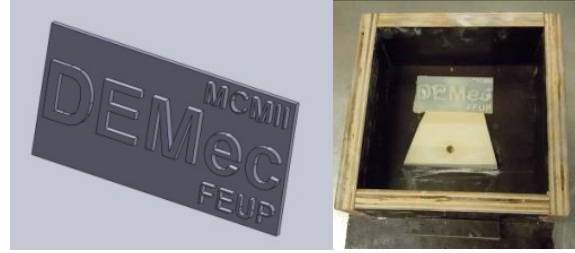
Figure 7. Image of the metallic plate to be obtained and SL prototype with the gating